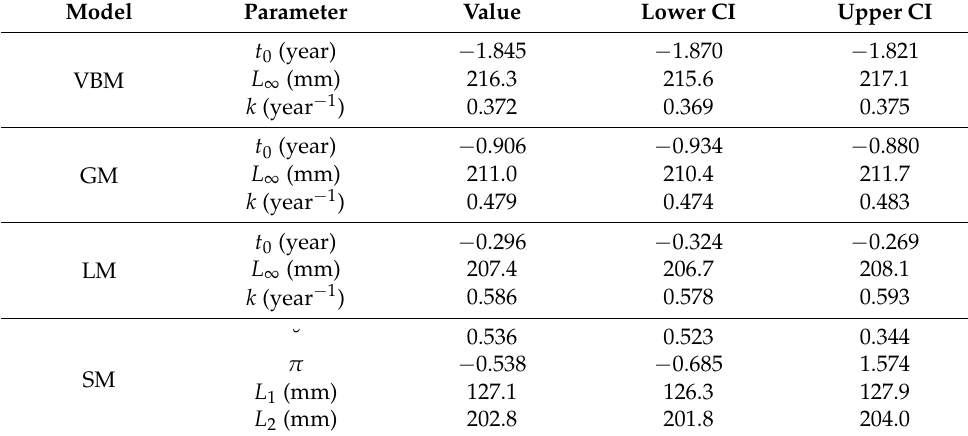
Table 4. Growth parameters values and 95% confidence intervals (CI; α = 0.05) estimated by